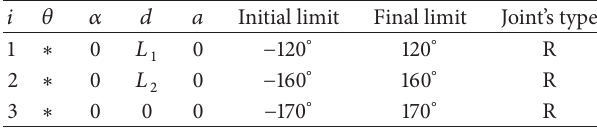
Table 2: DH parameters of planar